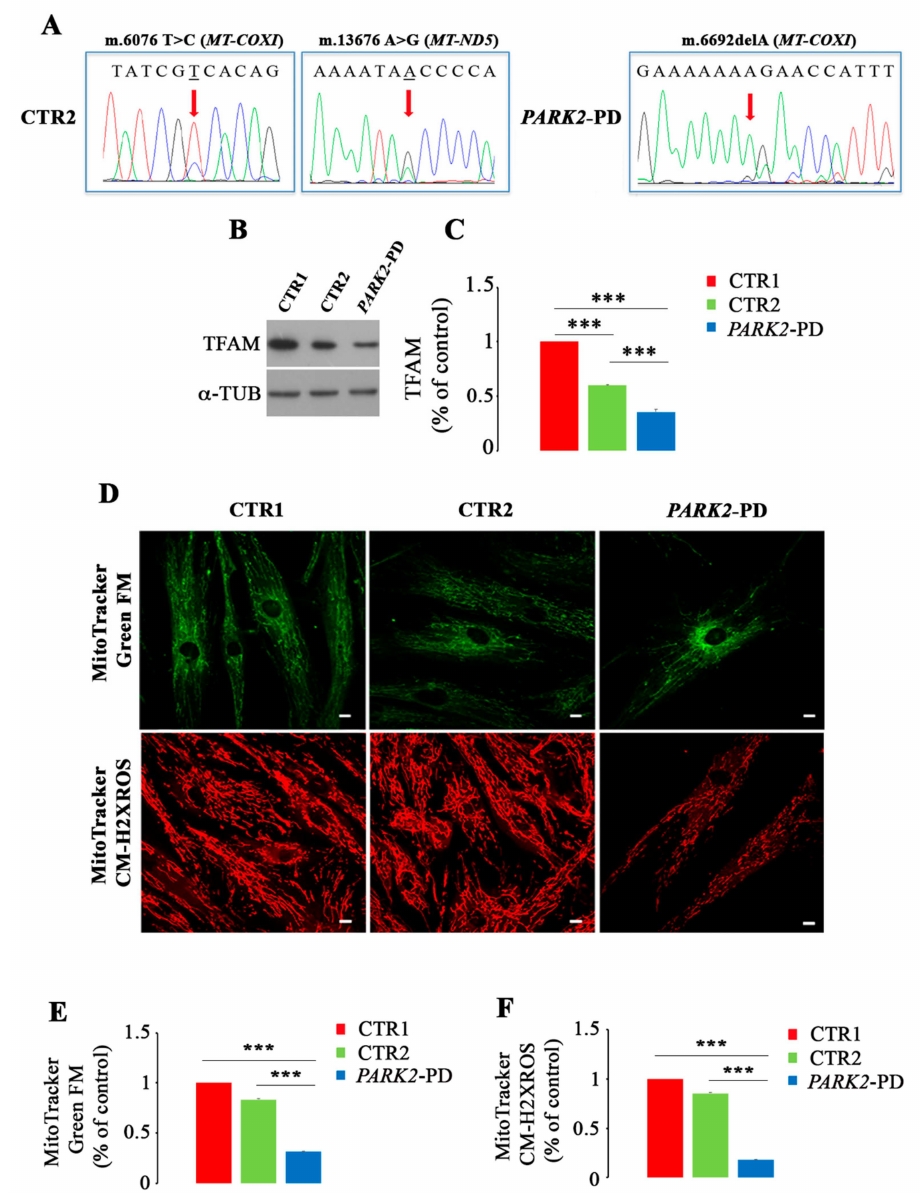
Figure 4. Mitochondrial defects in PARK2 -PD cells. ( A ) Electropherograms of mitochondrial loci harboring mutations in CTR2 and PARK2 -PD cells. Red arrows indicate the mutated and deleted bases. ( B , C ) Relative protein abundance of TFAM was assessed by western blotting and quantified by densitometry normalizing against α -tubulin. ( D – F ) Staining in live imaging of mitochondria with MitoTracker Green FM (green) and MitoTracker CM-H2XRos (red) in the three cell lines. Quantification of di ff erent intensities was performed with ImageJ software and represented in histograms (three independent experiments, ≥ 20 cells). Scale bar: 10 µ m. Data represent the mean ± SE of at least three independent experiments (* p ≤ 0.05, ** p ≤ 0.01 *** p ≤